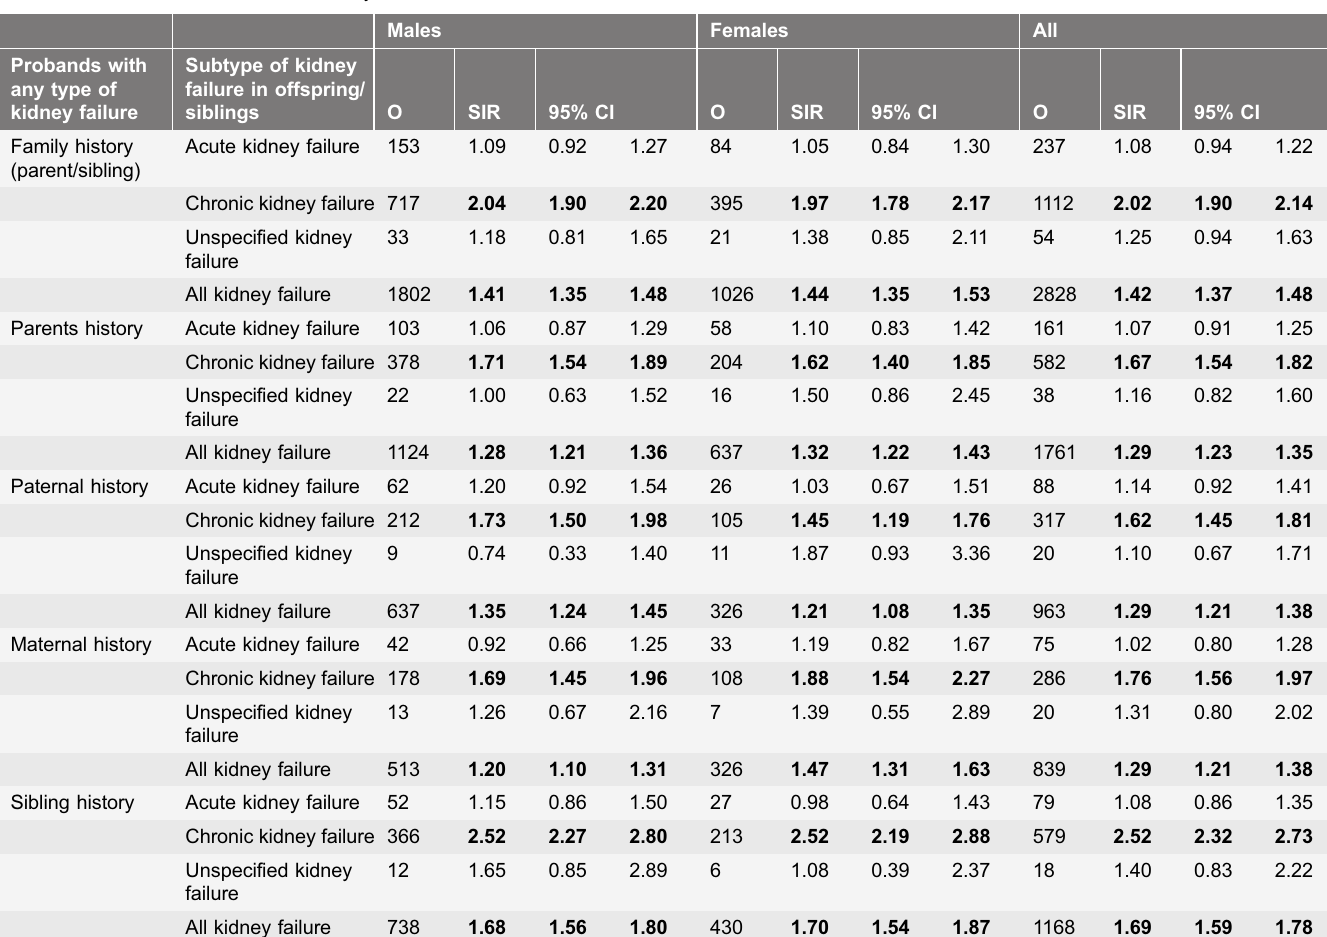
Table 3. Familial risk of concordant kidney failure in males and